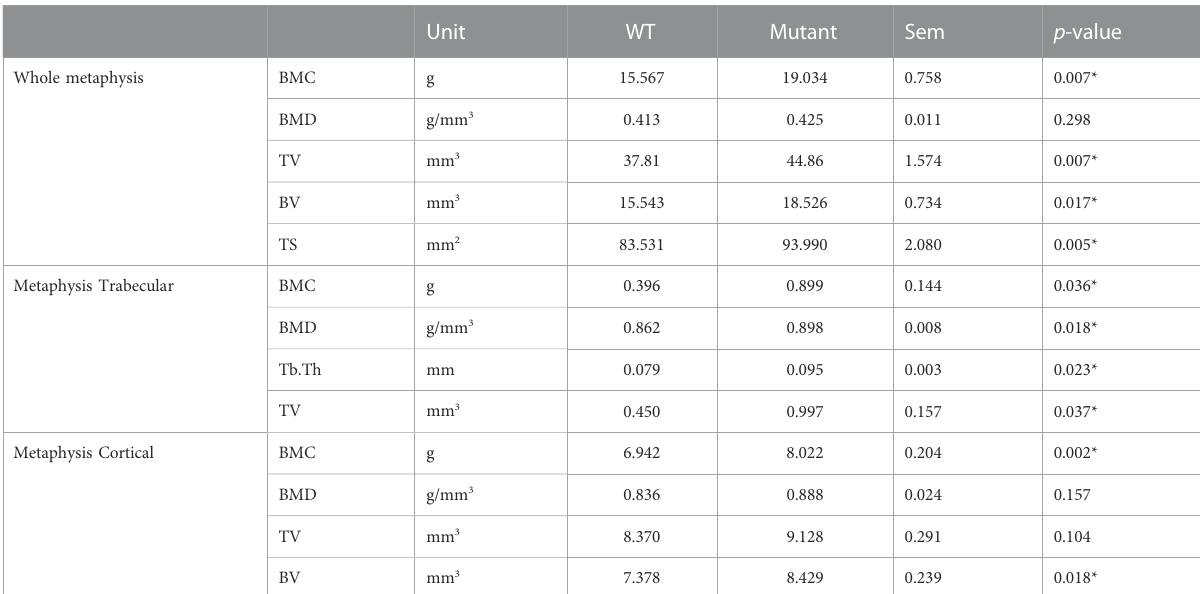
TABLE 3 Metaphyseal properties of WT and MSTN mutant tibia